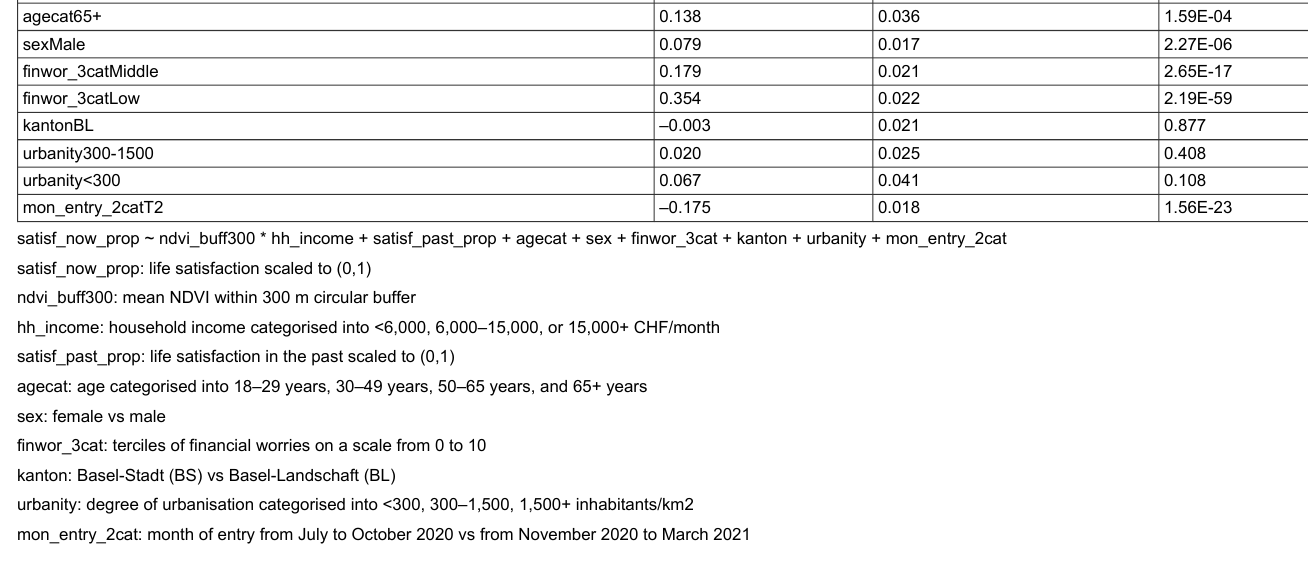
Table 3: Moderation by household income (likelihood ratio test p-value = 0.0049). Results from Beta regression of life satisfaction on NDVI by household income, adjusted for life satis- faction in the past, age categories, sex, financial worries, canton, degree of urbanisation, and month of entry.